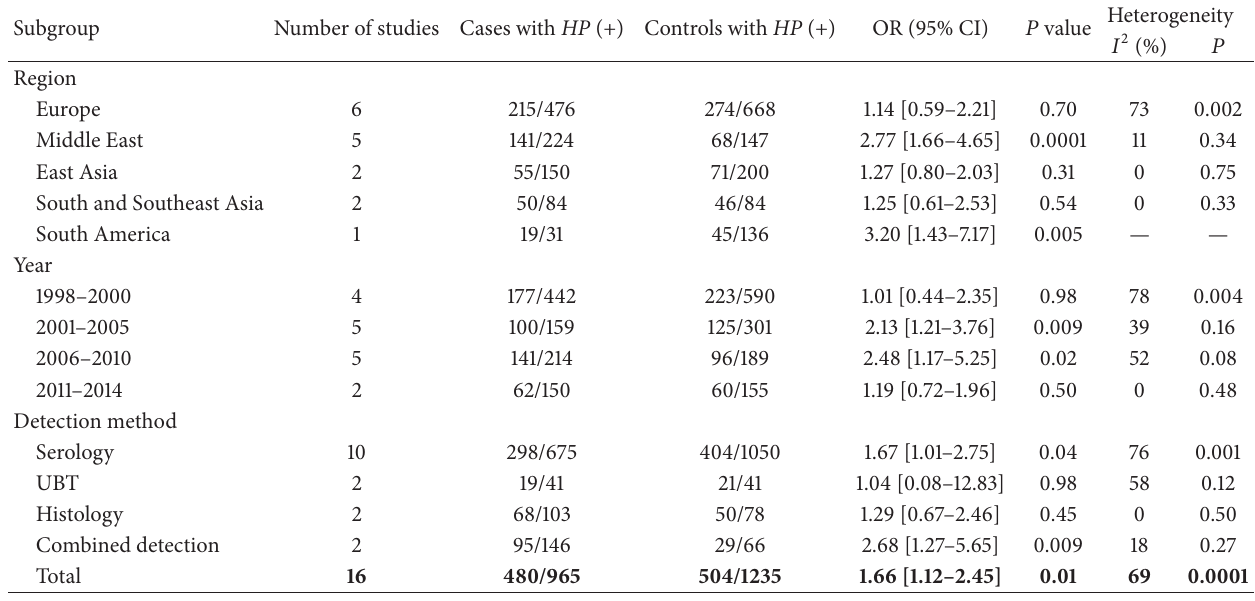
Table 2: Subgroup analysis of the prevalence of H. pylori infection in CU cases versus controls.